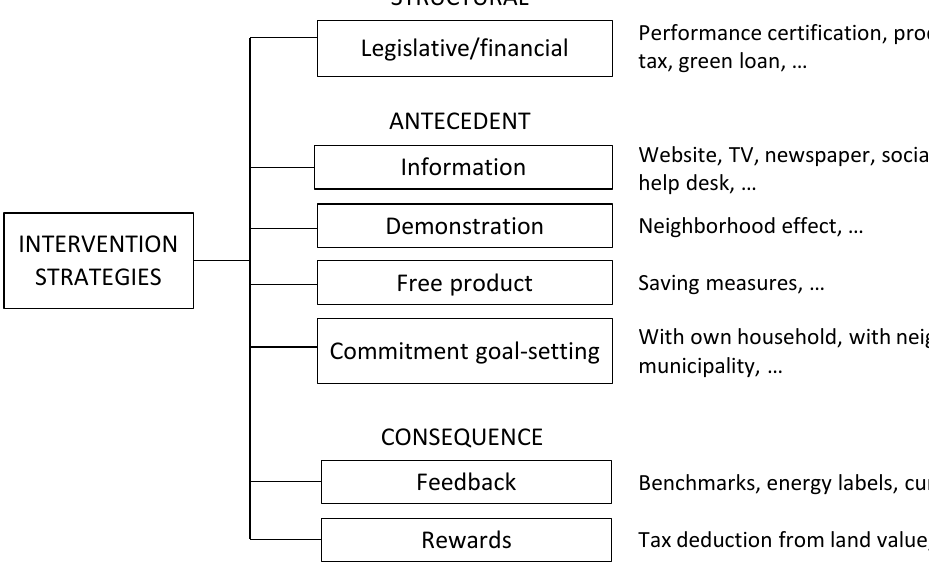
Figure 4. Major intervention